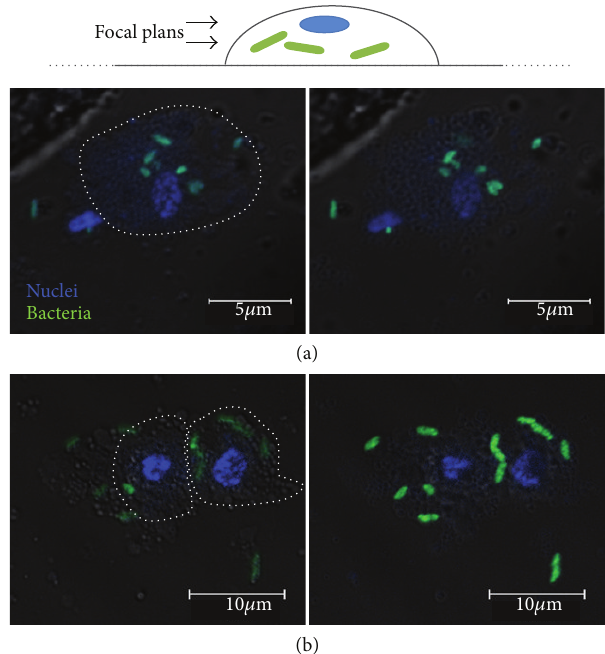
Figure 3: Phagocytosis activity of leech microglial cells. Following the dissection of leech nerve cord, microglial cells have been isolated and incubated in Ringer solution. Then heat-killed bac- teria ( Aeromonas hydrophila ) have been labeled with fluorescein isothiocyanate (FITC) to be incubated during 1 minute, 10 minutes, 20 minutes, or 6 hours in respective identical plates containing microglial cell culture at room temperature. Finally, after fixa- tion with 4% paraformaldehyde, the cytospinned cells have been incubated with a nuclear dye (10 𝜇 g ⋅ mL −1 Hoechst 33342), washed in 0.1 M PBS, and mounted for analysis by confocal fluorescent microscopy (blue, nuclei; green, bacteria). Only 10 minutes (a) and 6 hours (b) conditions are presented in the